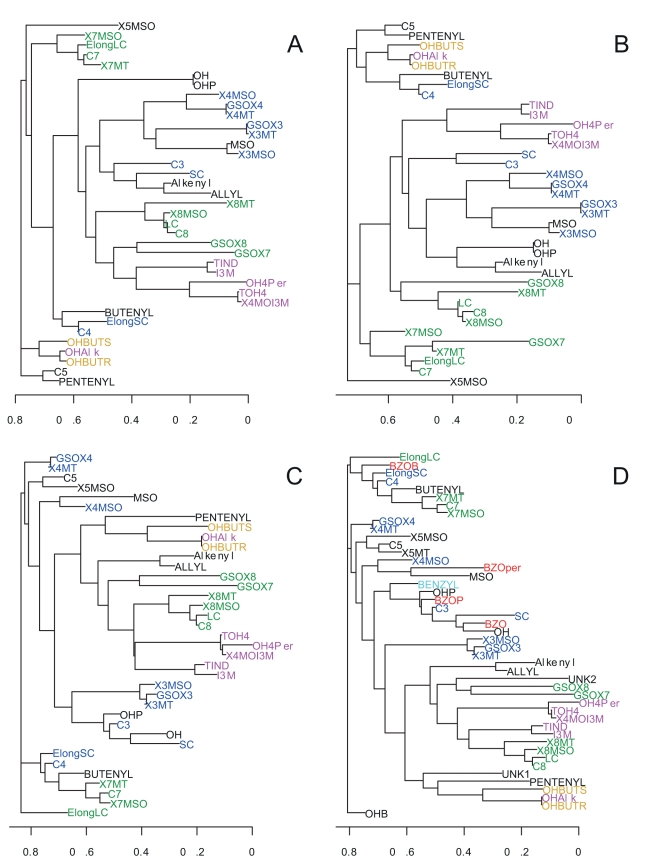
Clustering of traits from control, AgNO3-treated leaf, and seedling samples.Shown are neighbor-joining cluster trees of GSL traits where trait-trait distances were estimated based on trait values across the 96 accessions using Spearman's Rank Correlation Coefficient. The GSL were separated into four trait groups and the labels colored based on previous biochemical analysis; INDOLE, indolic GSL (Pink); OHBUT, 2-hydroxy-but-3-enyl GSL traits (Yellow); LC, 7 and 8 C long methionine derived GSL (Green); and SC, 3 and 4 C long methionine derived GSL (Blue). Two Seedling specific trait groups were also included for seedling specific GSL; BZO, benzoyloxy GSL (Red) and Benzyl (Cyan) are phenylalanine derived GSL. Abbreviations are as per Tables S1 and S2. For comparison, only traits available in all three datasets were included in the analysis for (A–C). (A) Relation of GSL traits in the control leaf dataset from the 96 accessions. (B) Relation of GSL traits in the silver leaf dataset from the 96 accessions. (C) Relation of GSL traits from the seedling samples from the 96 accessions. (D) Relation of all GSL traits from the seedling samples from the 96 accessions, including GSL traits not present in mature leaves.